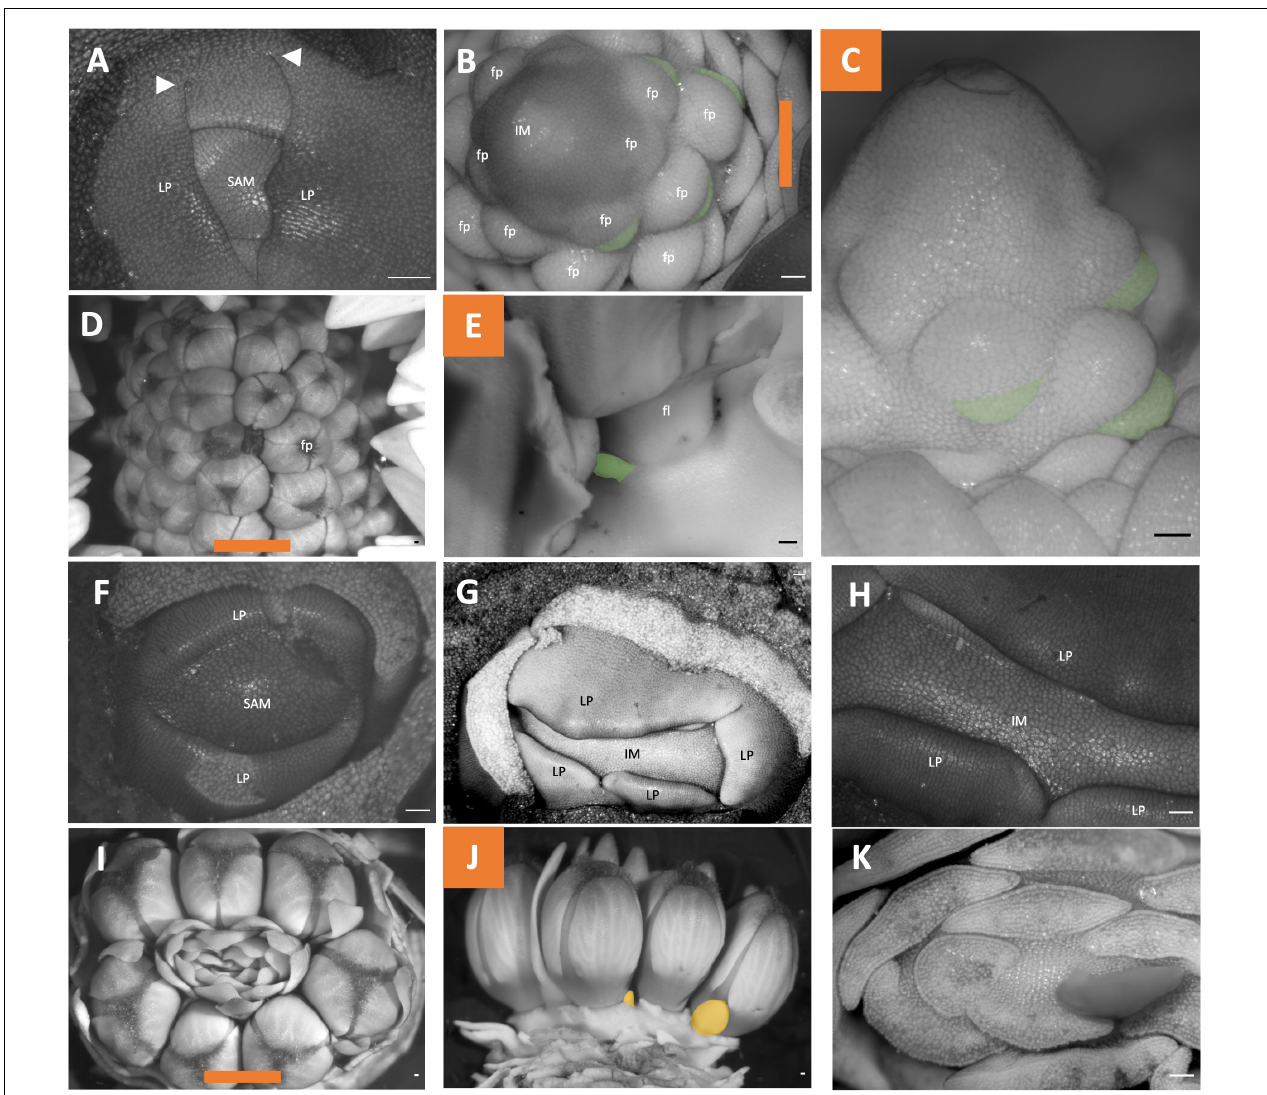
FIGURE 8 | Fritillaria inflorescence developmental morphology. (A–E) Fritillaria persica. (F–K) Fritillaria imperialis. (A) SAM. (B–C) Young inflorescence meristem with floral primordia. (B) imaged apically (C) , Imaged laterally. (D,E) Mature inflorescence (D) imaged apically (E) imaged laterally following dissection. (F) SAM. (G–H) Young inflorescence meristem exhibiting fasciation. (I–K) mature inflorescence (I) imaged apically (J) Imaged laterally following dissection of floral subtending bracts (K) Imaged apically following dissection of leaves. Colored lines on images taken from the apex (B,D,I) indicate orientation of the inflorescence in subsequent panels. Floral subtending bracts are false colored green (B,C,E) , floral bracts false colored orange (J) . White arrowheads indicate leaf fusion. SAM, shoot apical meristem; IM, inflorescence meristem; fp, floral primordia; LP, leaf primordia. Scale bar of all images: 100 µ